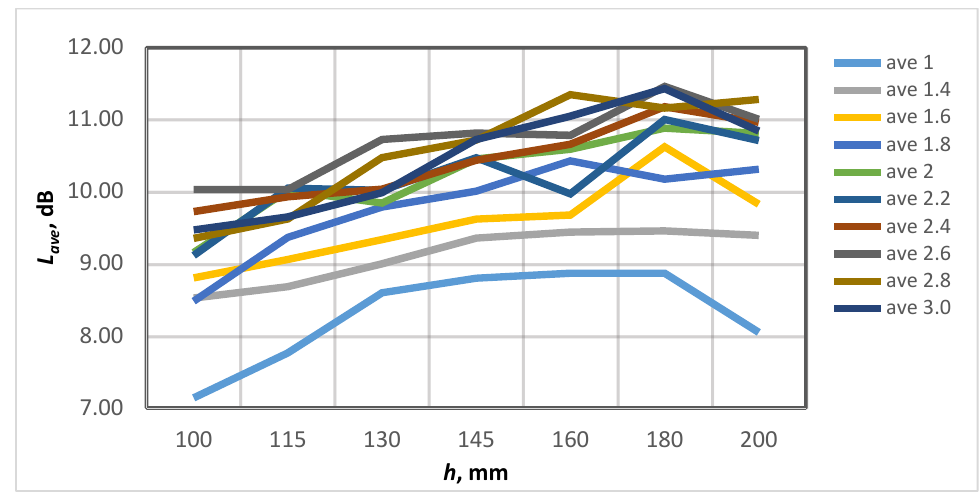
Figure 5. Average value of L ave (on the ordinate) for the different values of the central opening/inlet at the different values of a/b (on the abscissa are the different variants of a/b in ascending order).